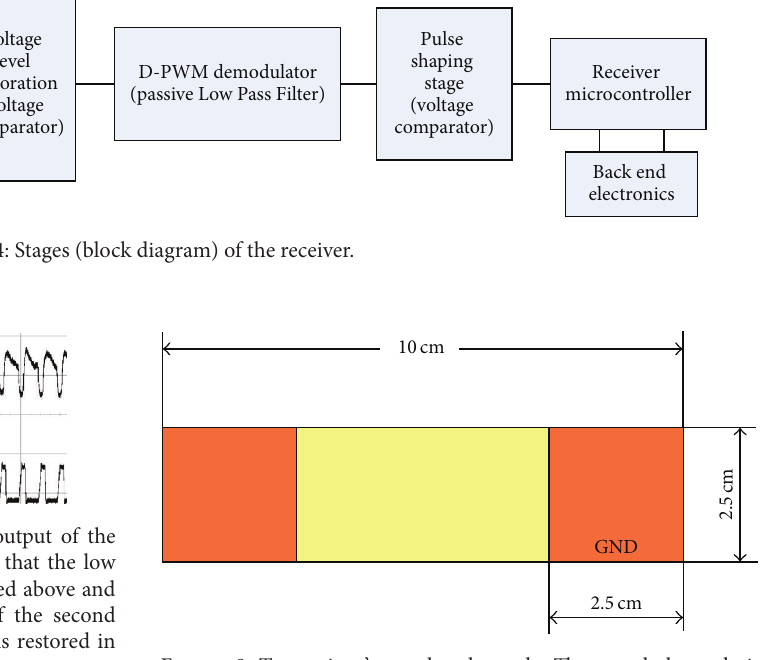
Figure 8: Transmitter’s coupler electrode. The actual electrode is made from copper covered printed circuit board. The copper has been removed from the middle area.